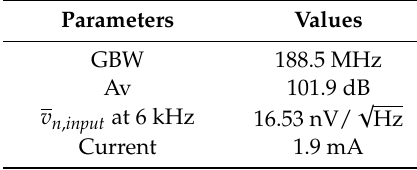
Figure 9. Transistor-level implementation of the amplifier. Table 1. The amplifier performances summary.